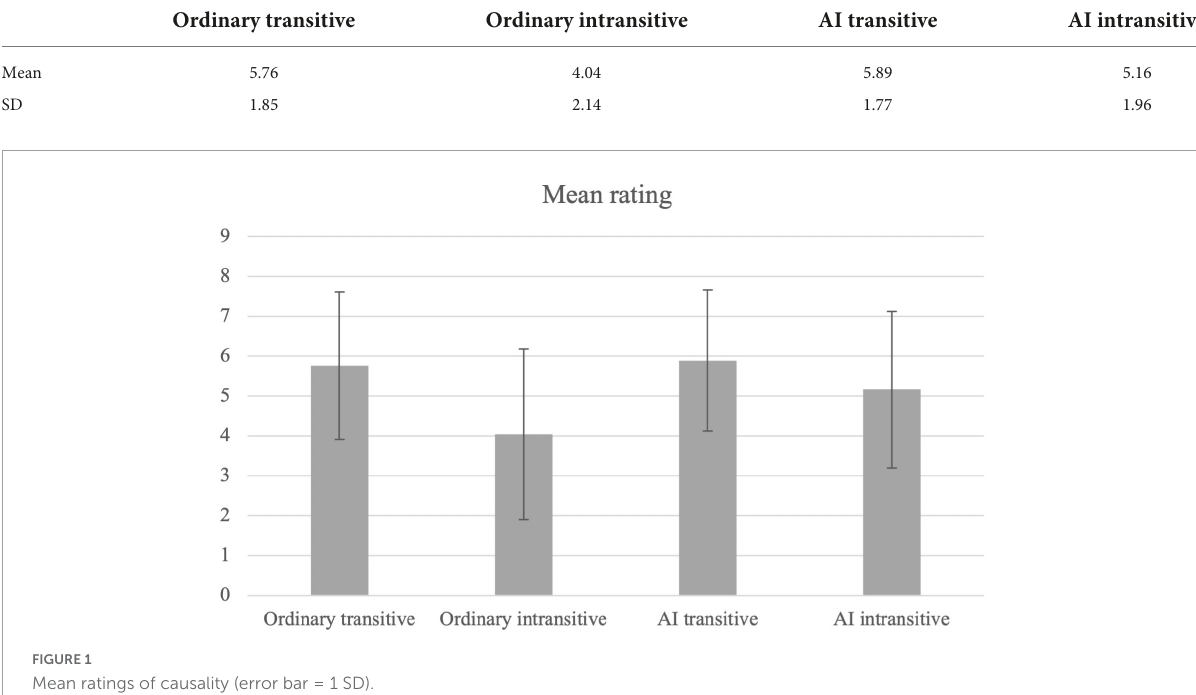
TABLE 2 Mean ratings of causality and standard deviations.